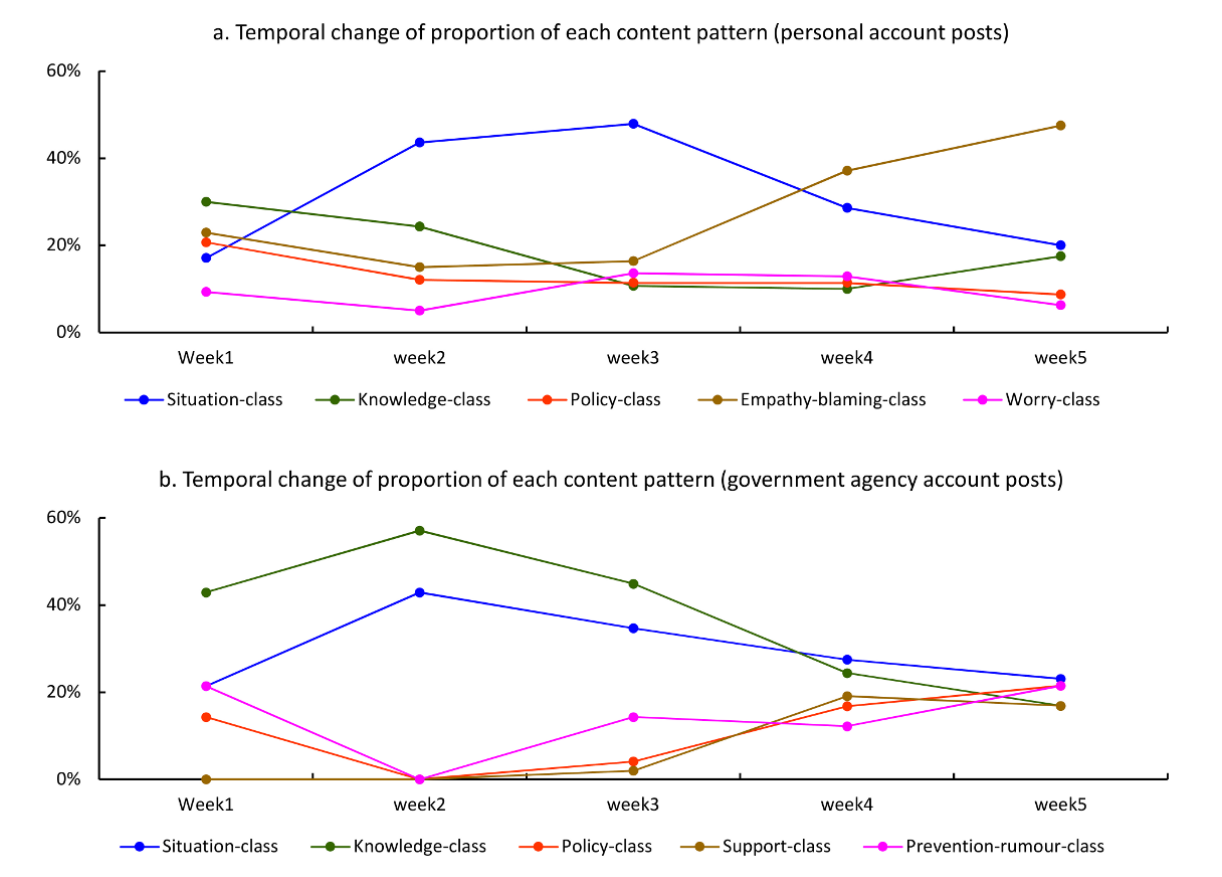
Figure 2. Temporal changes in the proportion of main content patterns by type of